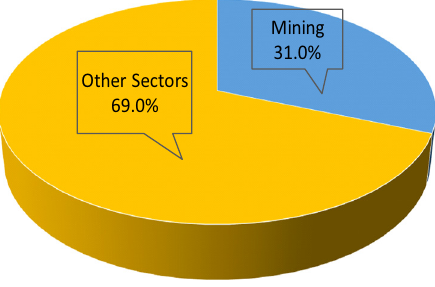
Figure 3: Proportion of mining sector in all EIA applications.